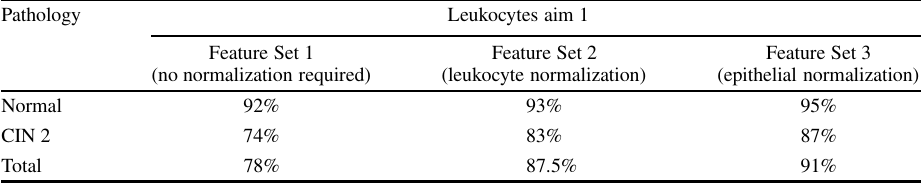
Cells-by-cells analysis: Percentage of correct classification after the stepwise discriminant analysis using the three features sets. F -to-enter, F -to-removed: 20